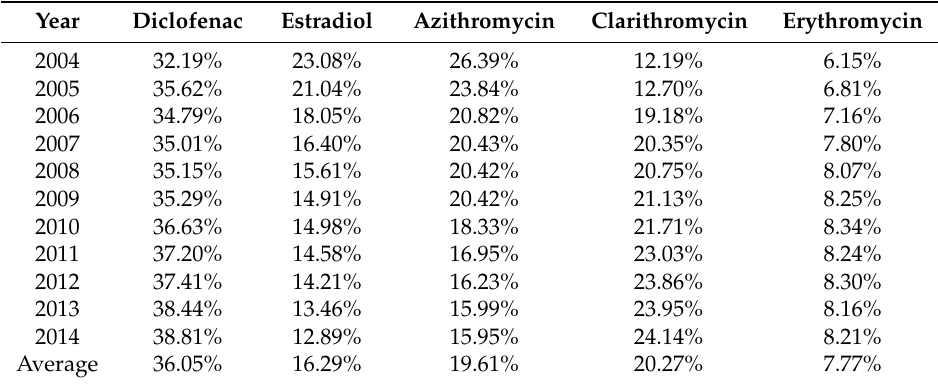
Table 1. Worldwide Yearly Averages of the Percentized Hits in the Five Examined Substances from 2004 to 2014.